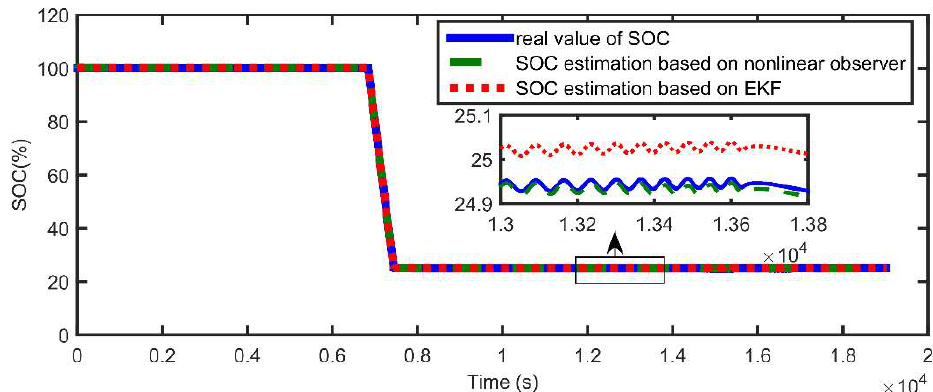
Figure 19. Voltage estimation error of test 2 under dynamic condition.